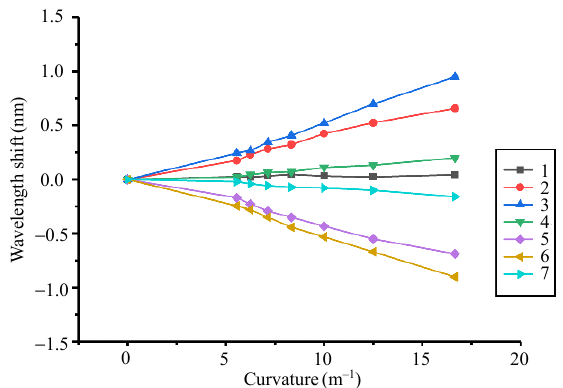
Fig. 7 Central wavelength shift of seven cores during the curvature sensing experiment.